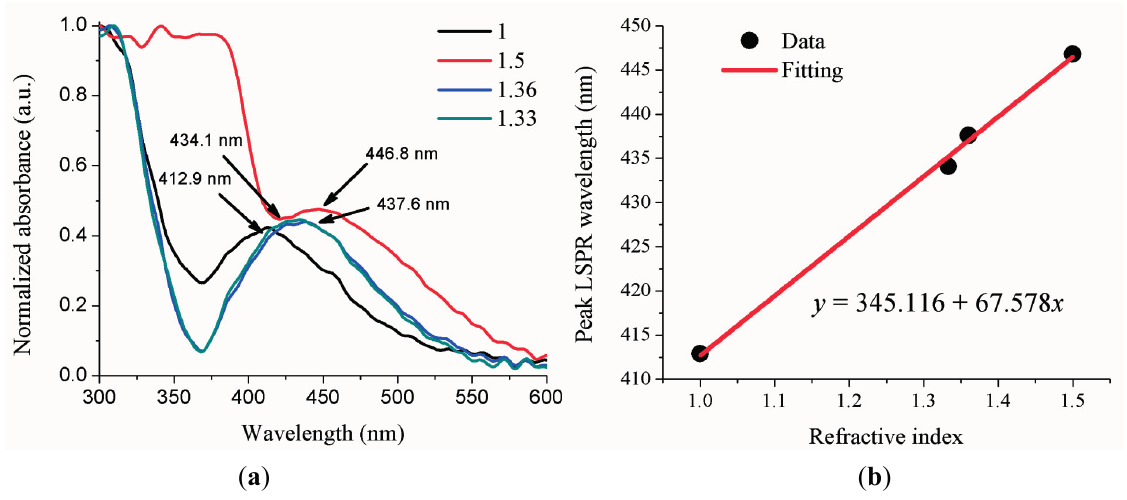
Figure 6. ( a ) Sensor response localized in air, deionized water, ethanol, and clove oil; ( b ) LSPR peak wavelength as a function of the refractive